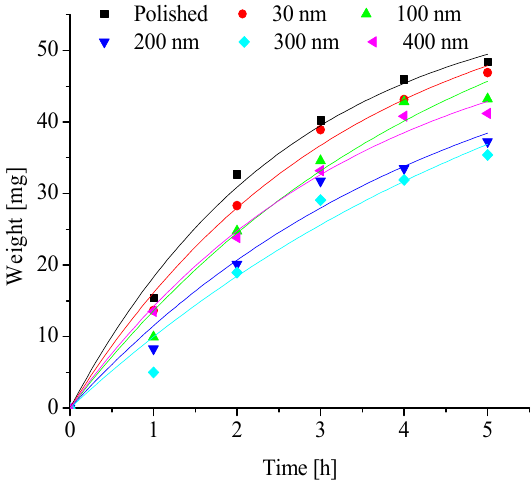
Figure 26. Testing value exponential model regression fitting at T = − 25 °C, φ = 90%.